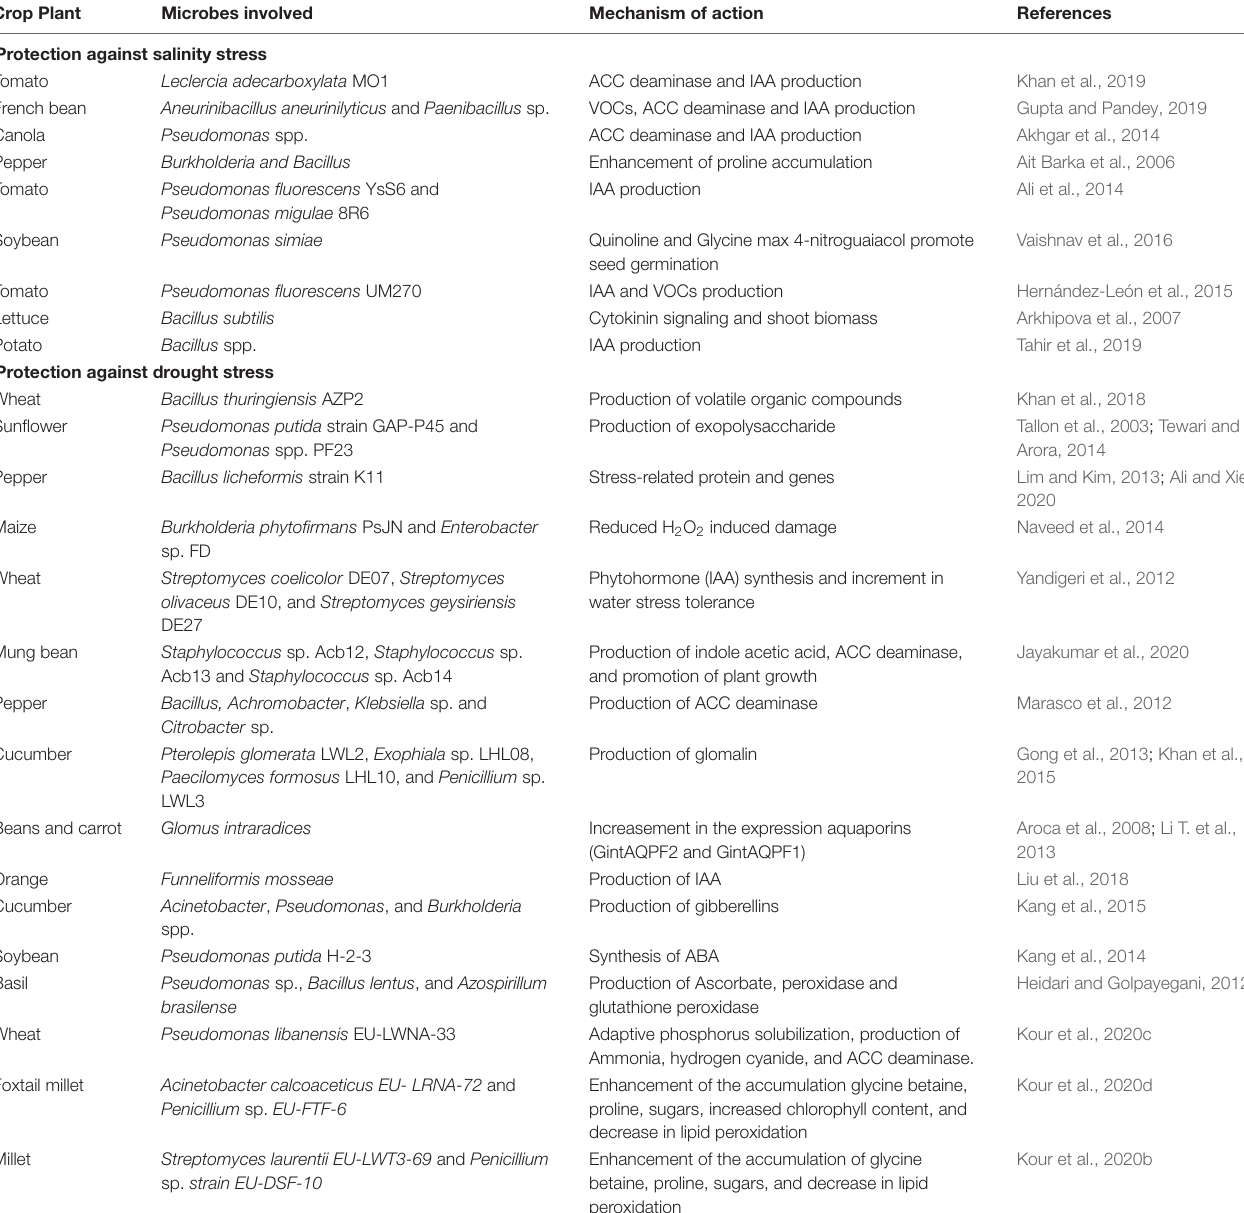
TABLE 2 | Microbial biostimulants that mitigate salinity and drought stress in